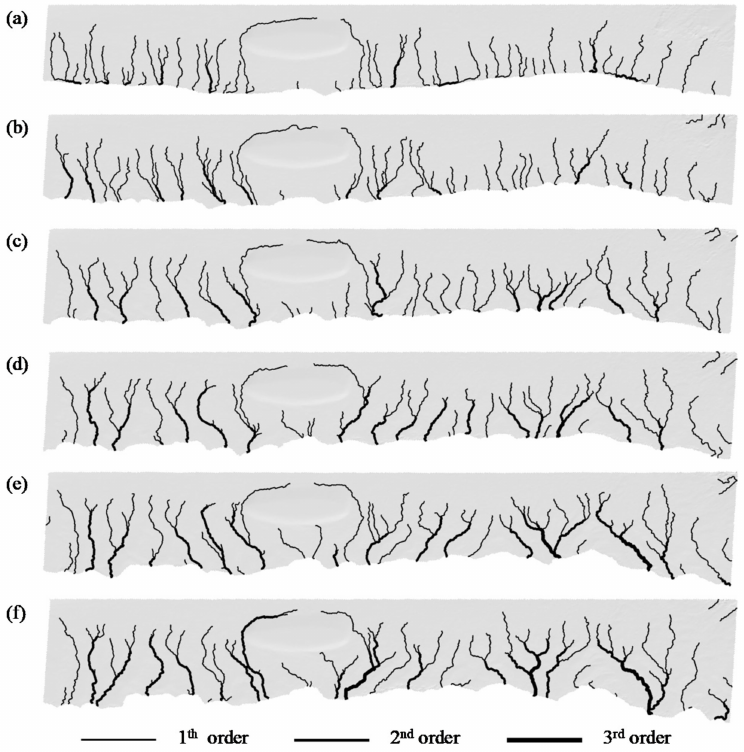
Figure 11. Tidal channel network formations after ( a ) 3, ( b ) 6, ( c ) 9, ( d ) 12, ( e ) 15, and ( f ) 18